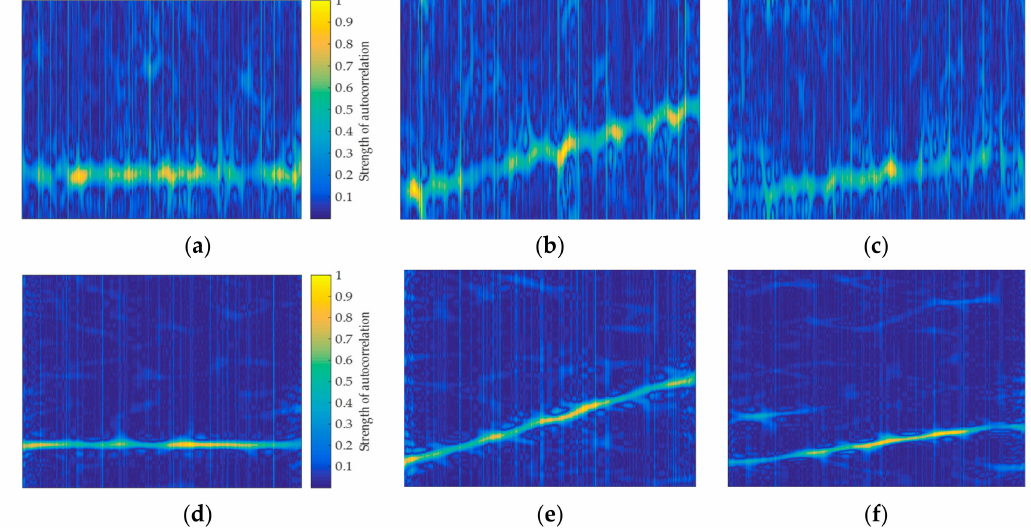
Figure 3. The signal time-frequency images (TFIs) when the SNR is 0dB, the first row represent the images generated by Kaiser window, and the second row represent the images generated by Hamming window: ( a ) Single frequency; ( b ) LFM; ( c ) P1; ( d ) Single frequency; ( e ) LFM; and, ( f )